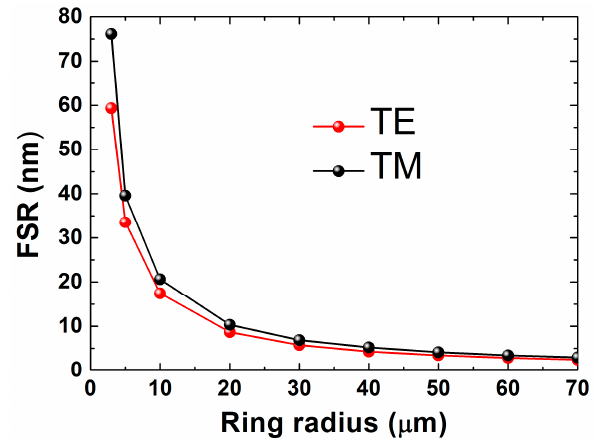
Figure 6. FSR of microring resonators as different ring radii. The modes were calculated at λ = around 1.55 μ m.